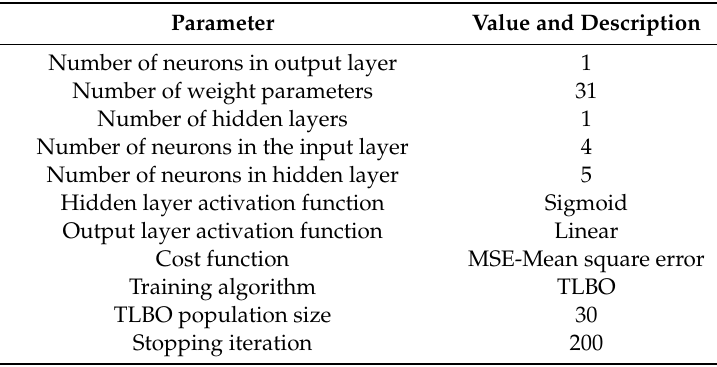
Table 5. ANN and TLBO